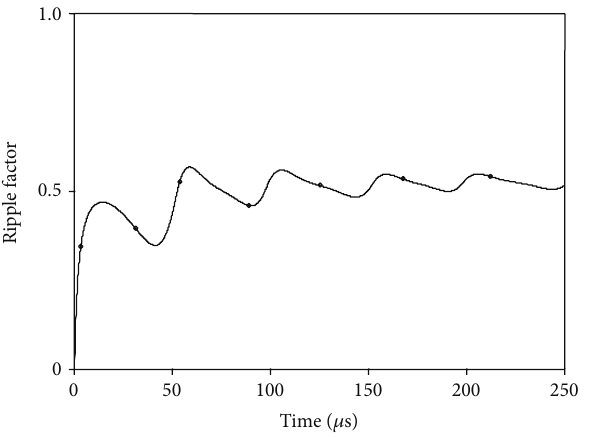
Figure 6: Simulated curve for ripple factor.